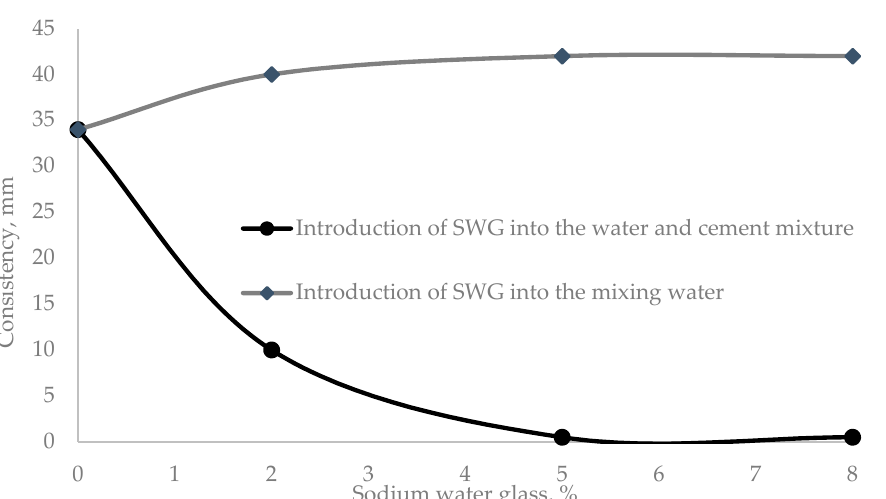
Figure 1. Dependence of the consistency of the cement paste on the amount of WG admixture and the method of its introduction. Table 4. Results of the setting times of cement pastes, depending on the method of introducing water glass